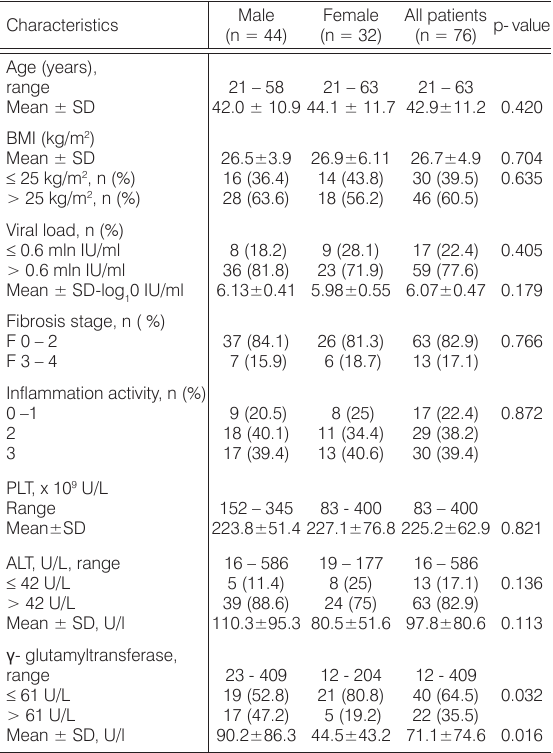
Table 1. Baseline characteristics of the study